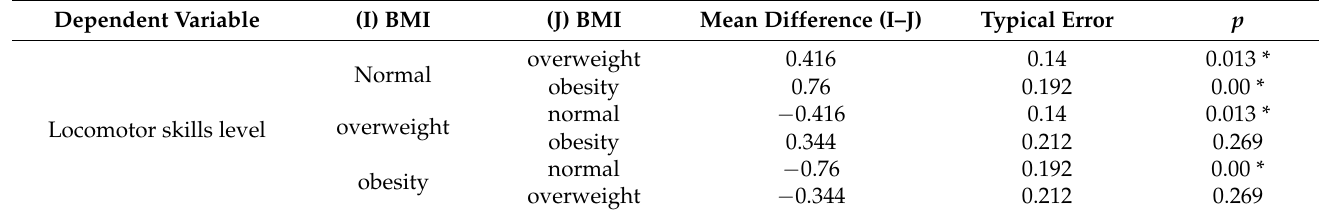
Table 4. Significant differences in the level of displacement between groups of